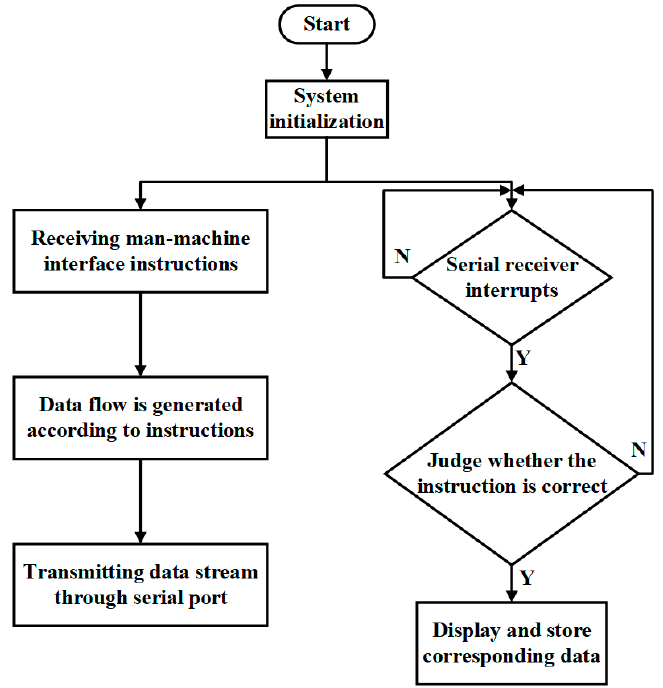
Figure 15. Software design flow chart of the upper machine.